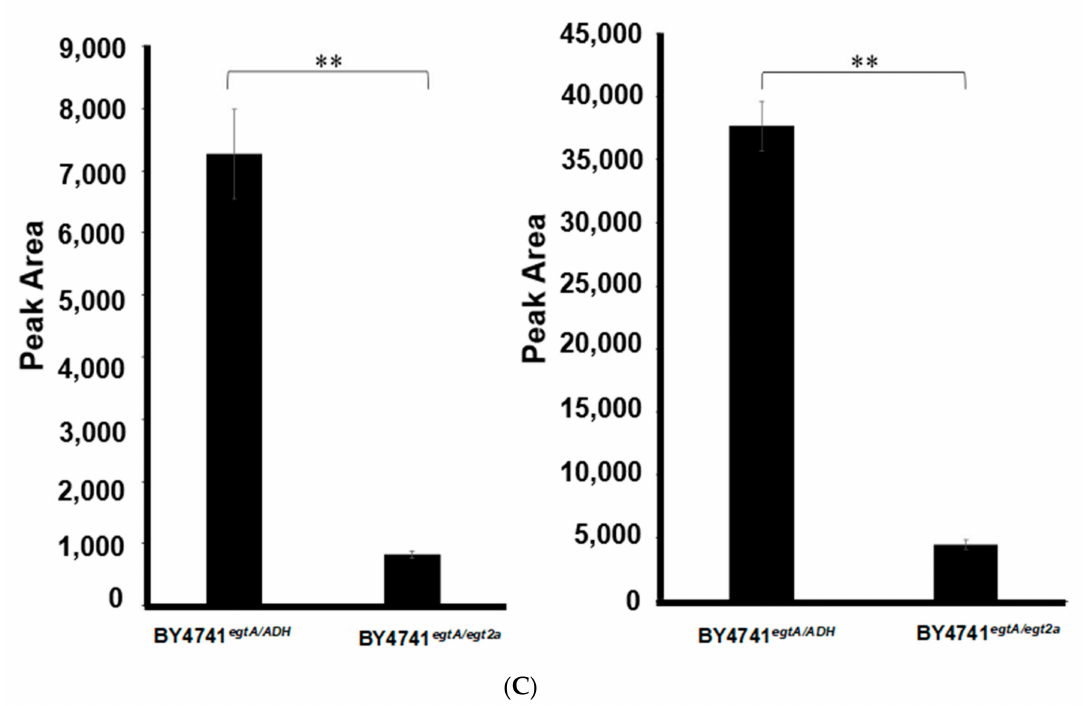
Figure 5. ( A ) Western Blot confirmation of Egt2a expression in BY4741 egt2a- His : Lane 1 = protein ladder 175–177 kDa; Lanes 2–5 = independent samples of His-tagged Egt2a protein (50 kDa) from S. cerevisiae BY474 egt2a- His ; Lanes 6–7 = negative control BY4741 egt2a cell lysate; ( B ) EGT production in BY4741 egtAegt2a is confirmed. Left panel shows EGT in BY4741 egtAegt2a (retention time: 13.84 min (black) compared with the EGT standard 13.85 min (red)). Right panel shows EGT in BY4741 egtAegt2a at a retention time of 13.84 min (black) compared with the BY4741 p426-GPD p423 ADH where EGT is absent; ( C ) release of significantly less extracellular EGT from BY4741 egtAegt2a than from BY4741 egtAp423-ADH . Left panel shows culture supernatant EGT peak areas after 48 h and show significantly higher levels [**] ( p = 0.0063) of EGT in BY4741 egtAp423 ADH than in BY4741 egtAegt2a . Right panel reveals peak areas from EGT supernatant at 72 h which show significantly higher levels [**] ( p = 0.0018) of EGT in BY4741 egtAp423 ADH than in BY4741 egtAegt2a